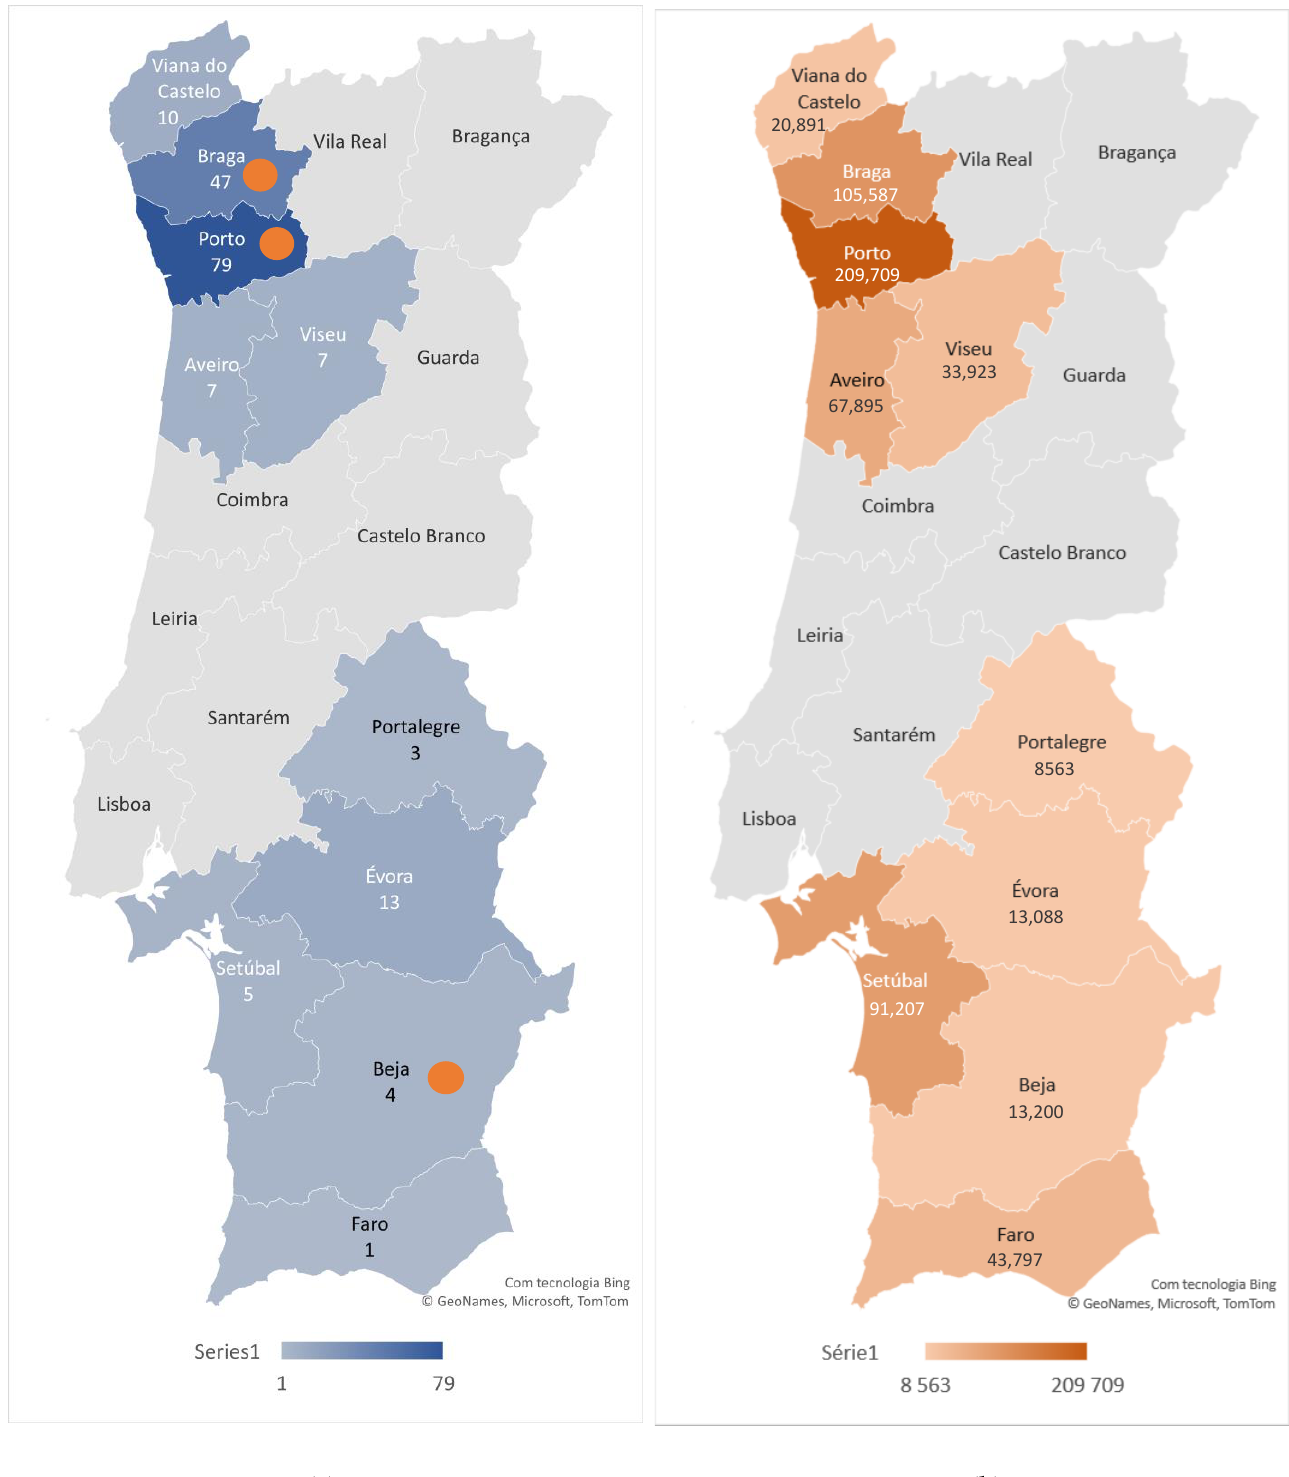
Figure 1. Geographical distribution of sampled cats and cumulative human COVID-19 cases. ( a ) The number of sampled cats by district is shown by the color gradient, as indicated in the legend. The district of residence of SARS-CoV-2-positive cats is marked with a circle. ( b ) The number of cumulative human COVID-19 cases at the end of October 2021 by district is shown by color gradient, as indicated in the legend.